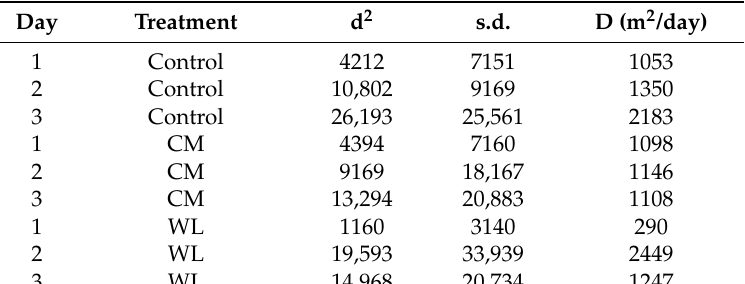
Table 4. Mean squared distances (d 2 ) and dispersal constants (D) of Anartia fatima during the first three days following their October release.